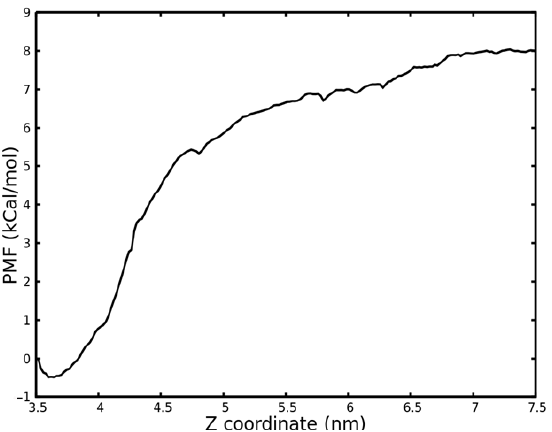
Figure 7. Potential of Mean Force (PMF) energy values of the simulated KRSR peptide–TiO 2 surface interaction as a function of the Z coordinate.